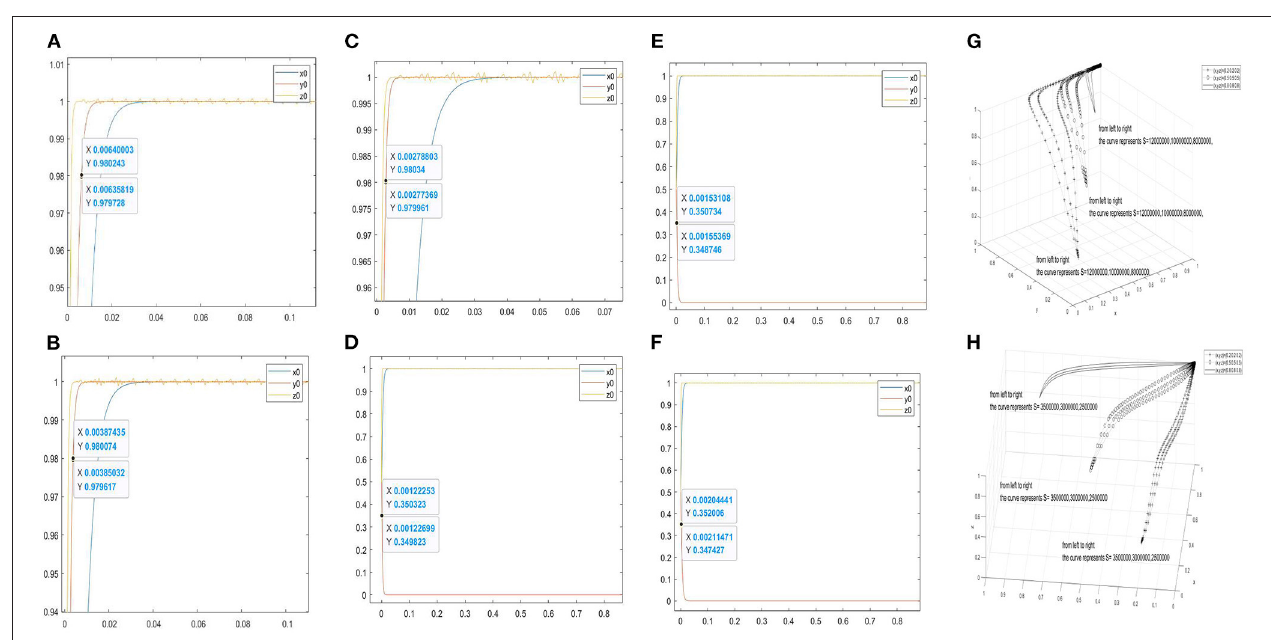
FIGURE 3 | Evolutionary simulation results of the parameter S . (A–C) the value range of the abscissa when the ordinate is 0.98 under different factors. (D–F) the value range of the abscissa when the ordinate is 0.35 under different factors. (H,G) the three-dimensional comparison diagrams under the three-way selection ratio.